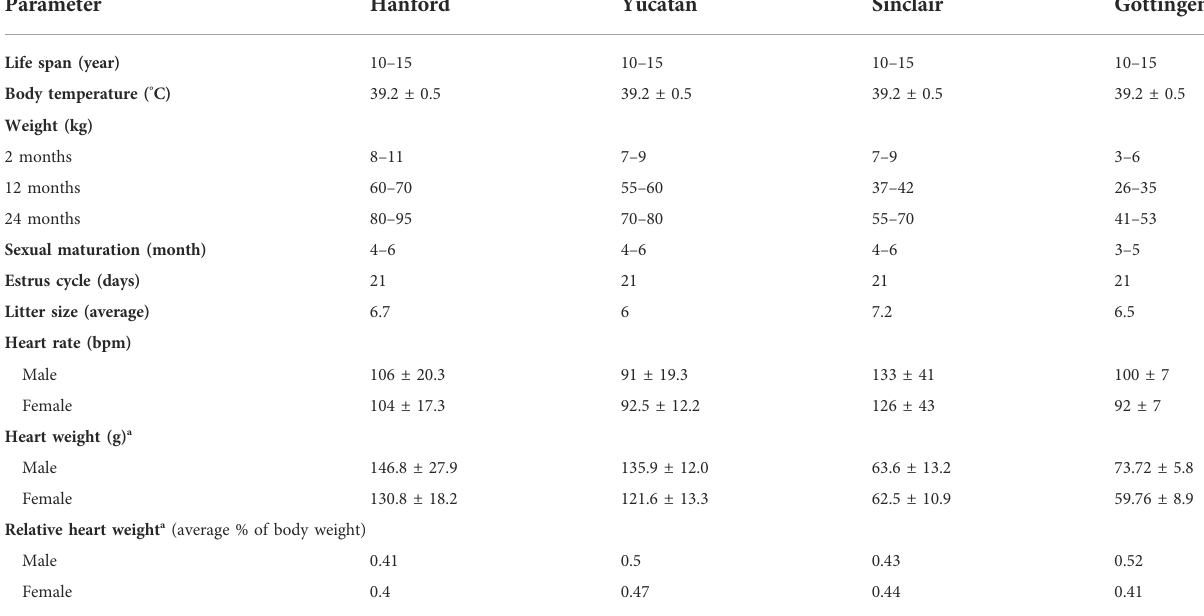
TABLE 2 Comparison of various Miniature pig